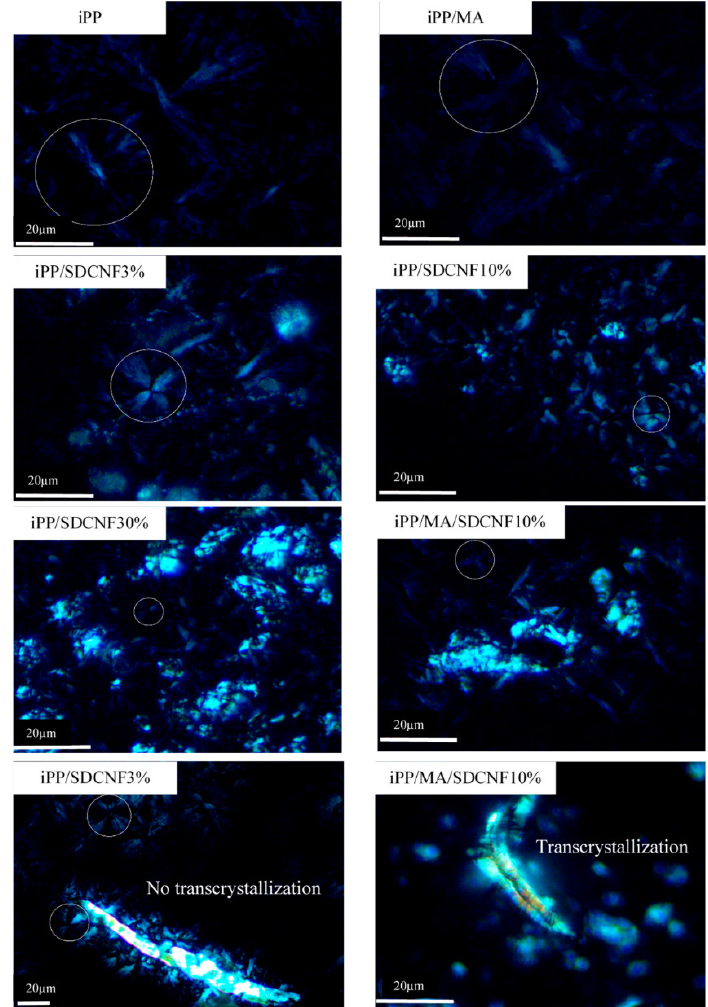
Figure 5. Polarized light micrographs of iPP and iPP/SDCNF composites. Bright and irregular-shape clumps represent SDCNF. Inside the circles are the Maltese-cross patterns of iPP spherulites. The last two graphs show the effect of maleic anhydride polypropylene (MAPP) on trans-crystallization using different scale bars. Reprinted from [24] with permission from